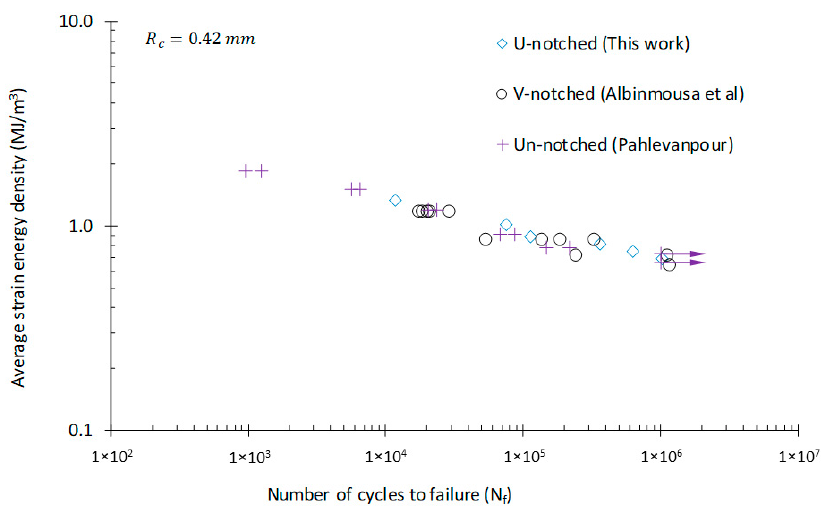
Figure 10. Correlation of the strain energy density and fatigue life of unnotched and U- and V- notched specimens [34]. Reproduced from [34], with permission from Elsevier,